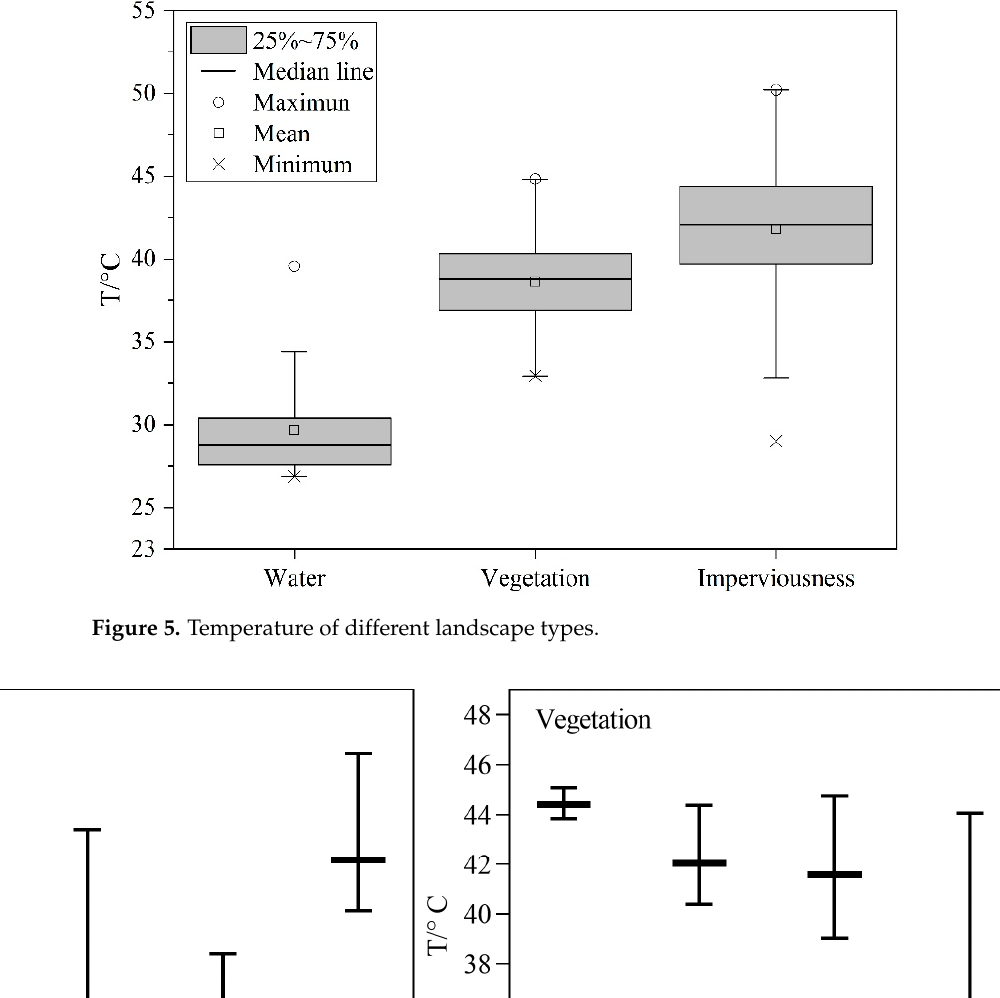
Figure 4. Classification of urban heat islands in 2000 and 2016.